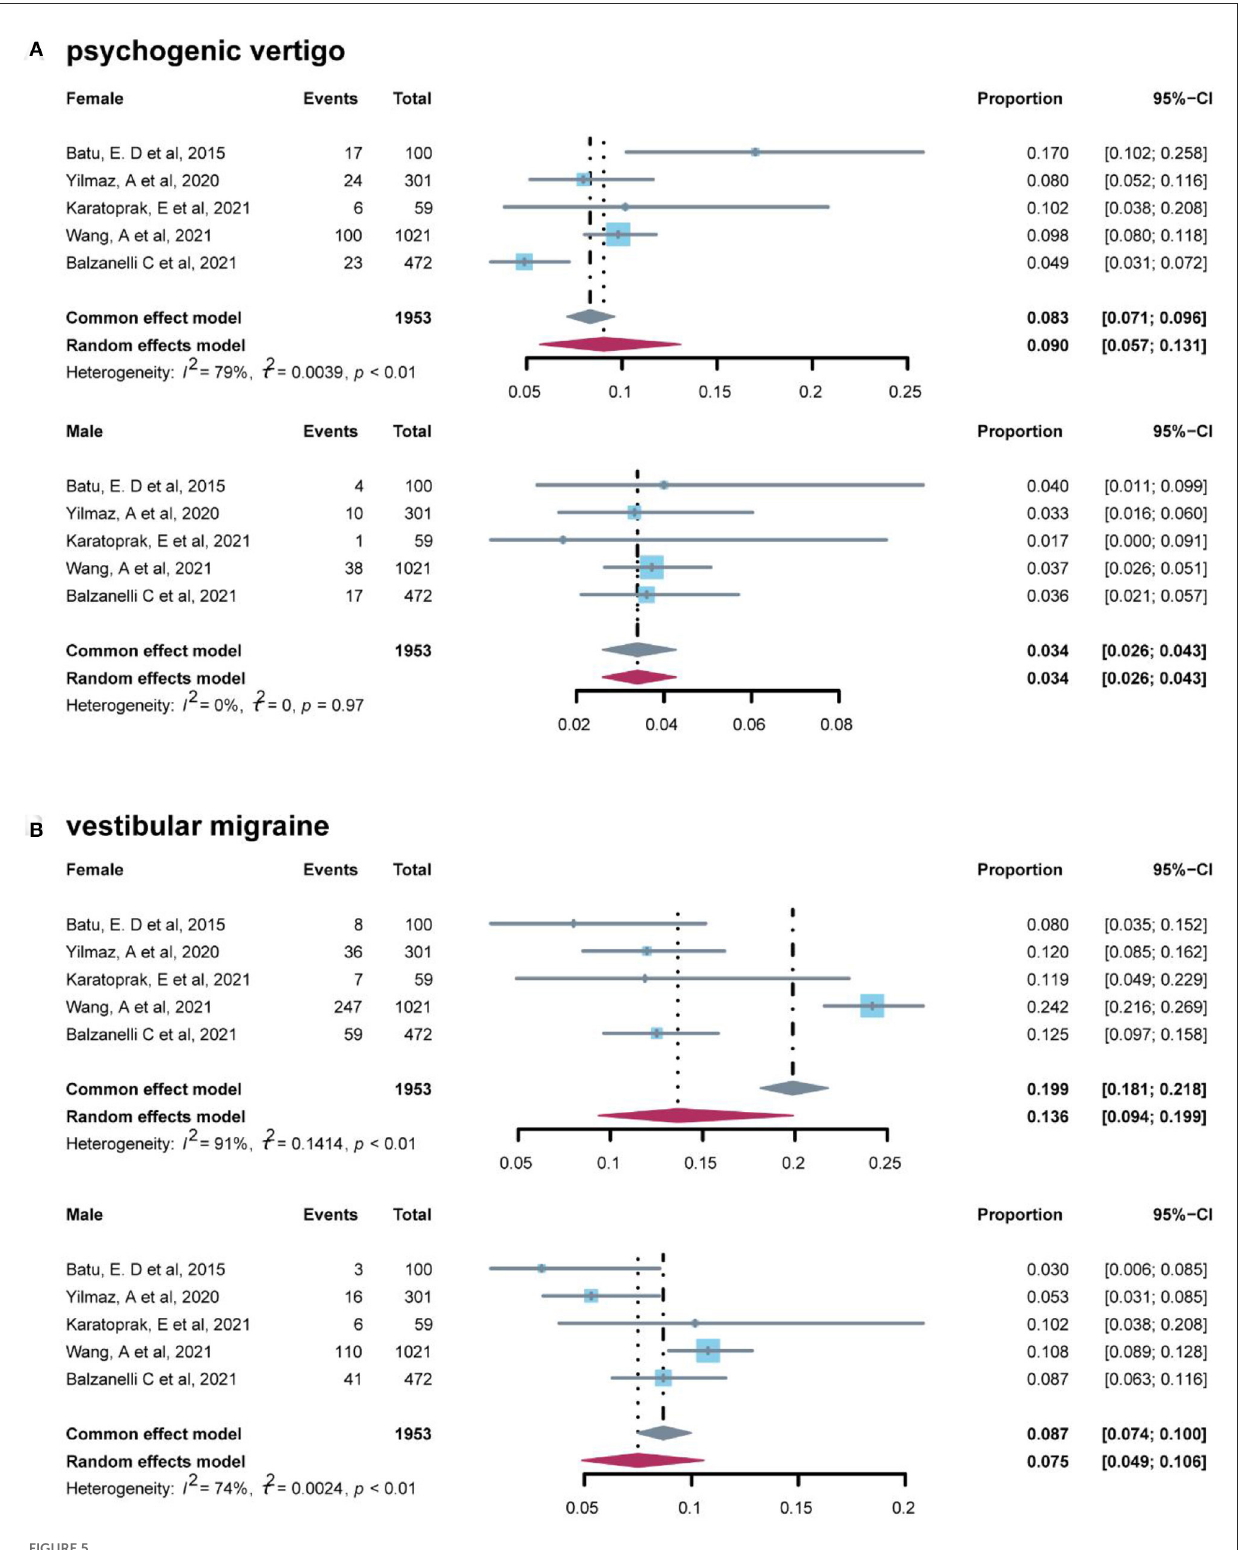
FIGURE5 Forest plot of psychogenic vertigo and vestibular migraine in female and male.